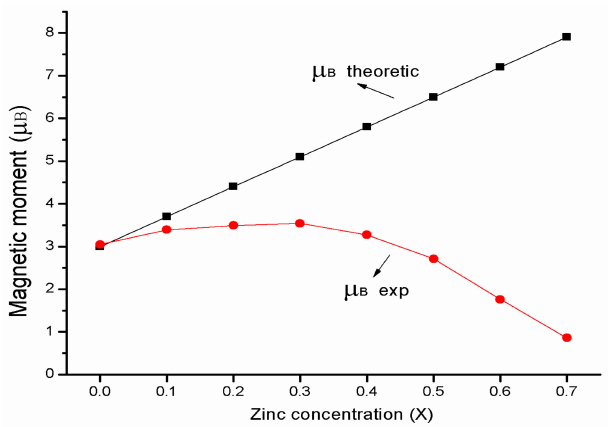
Figure 9. Variation in experimental and theoretical magnetic moment with Zinc content x